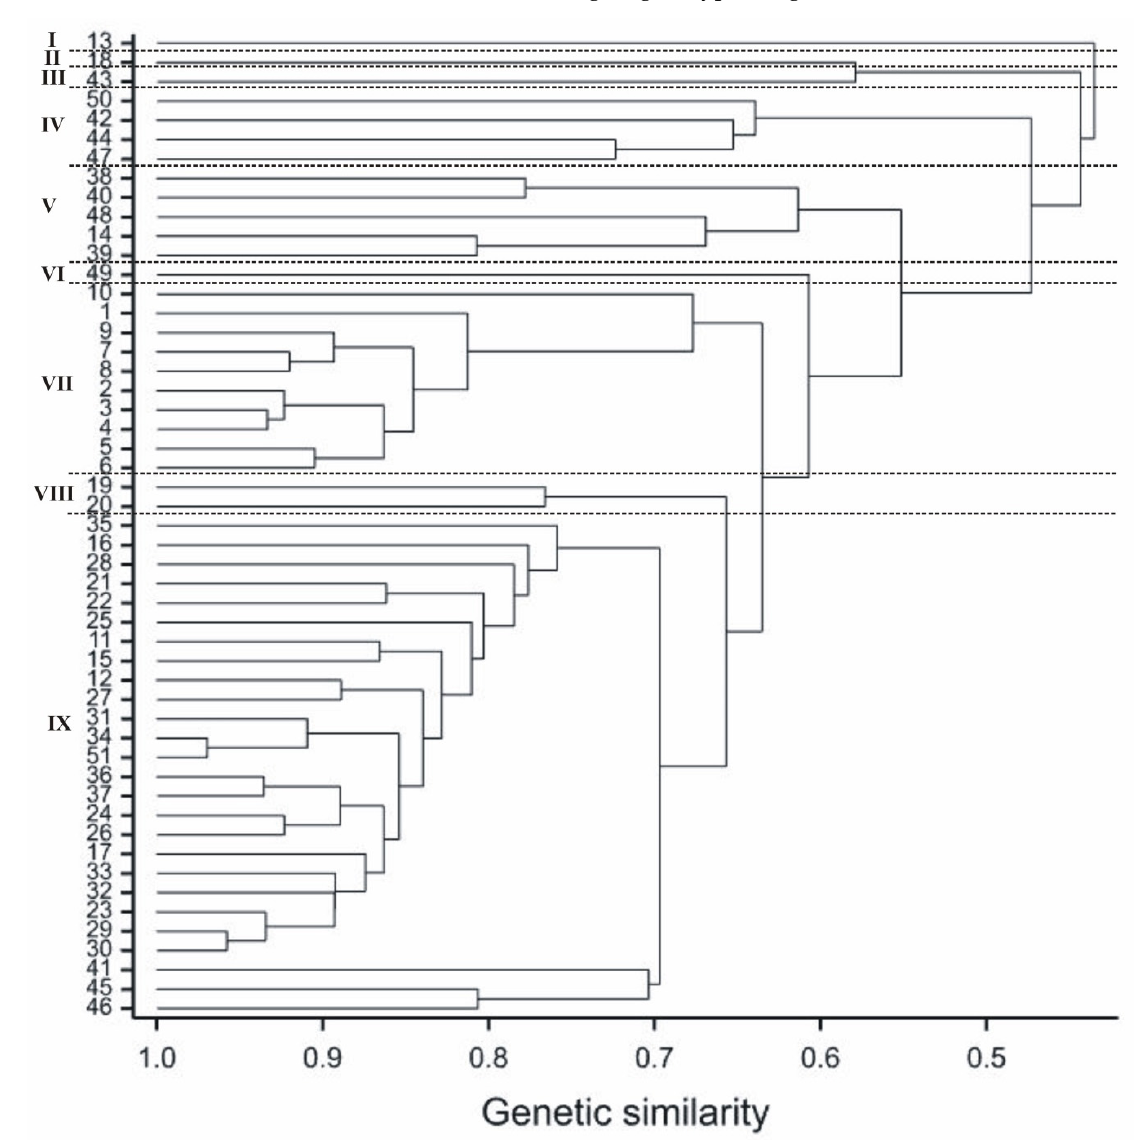
Figure 2. Dendrogram obtained from SSR data showing the genetic relationship of studied genotypes (numbers according to Table 1). Genotypes were grouped hierarchically using the UPGMA method. The scale at the bottom of the dendrogram indicates the level of similarity between individual plants.